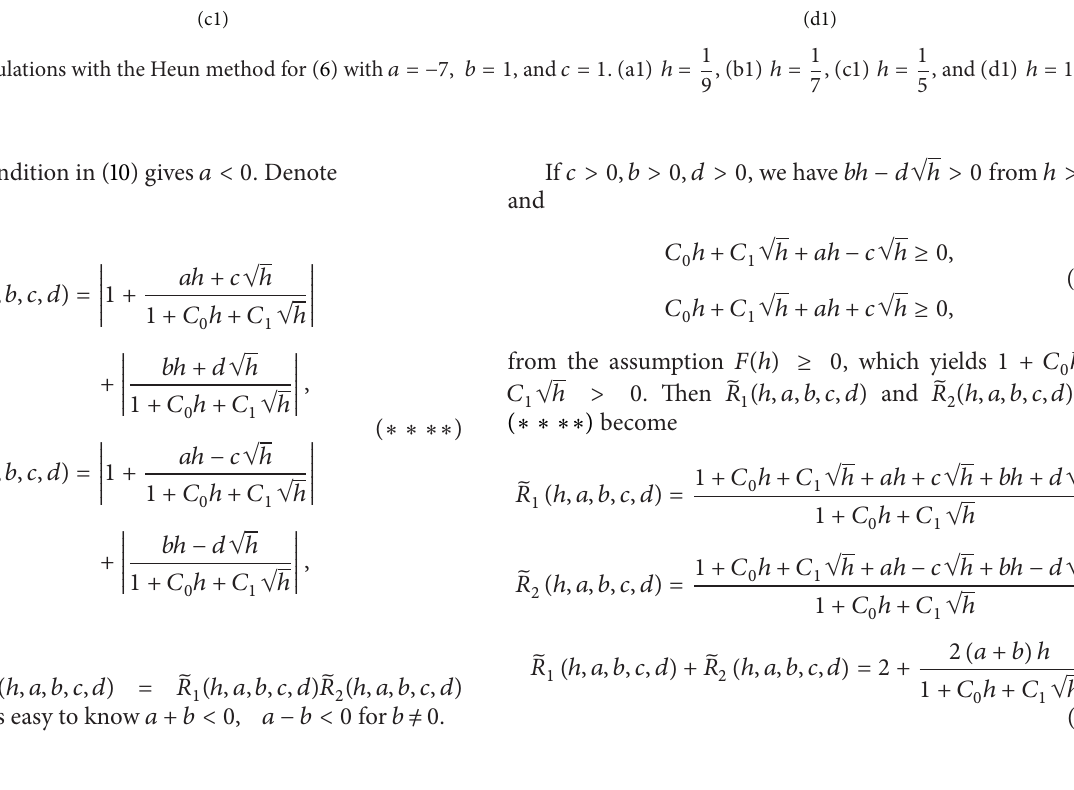
1 1 1 ( b 1) ℎ = ( c 1) ℎ = ( d 1) ℎ = 1/3 9 , 7 , 5 , and